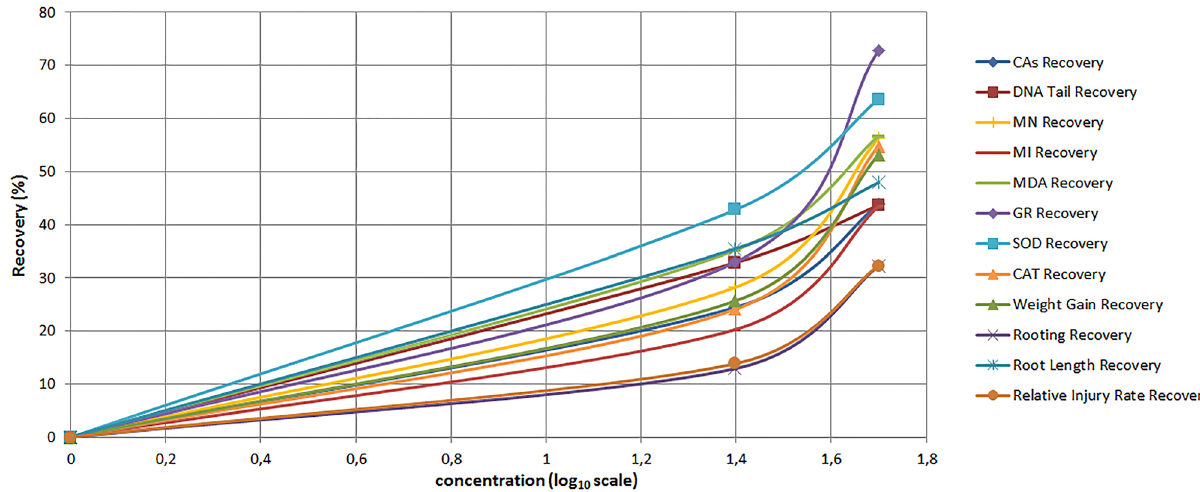
Figure 8. Dose–response protection curves of BBE against penoxsulam